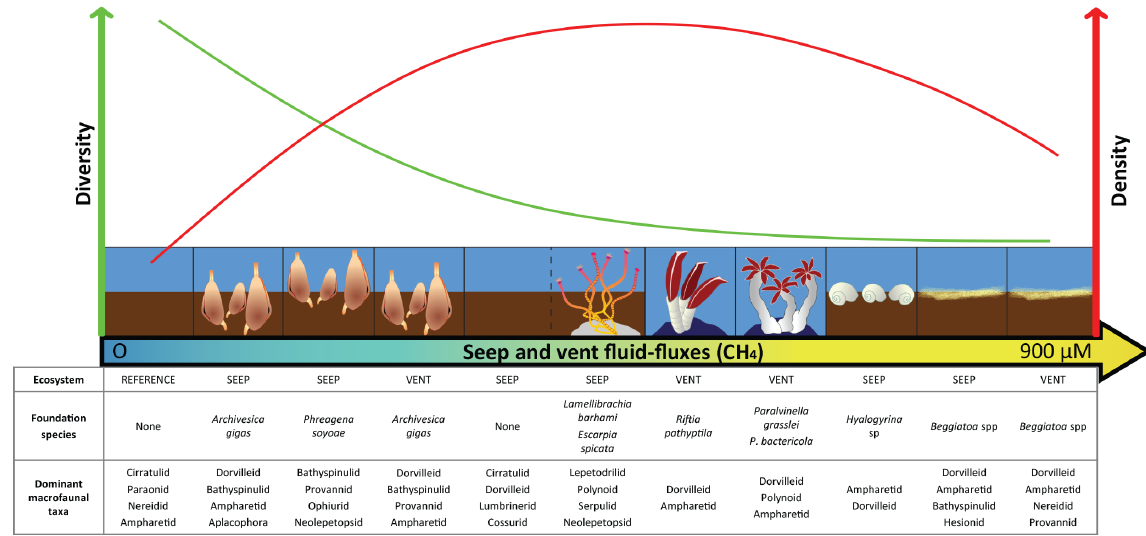
Figure 10. Conceptual diagram of macrofaunal diversity, density and composition patterns along a fluid-flux gradient in the chemosynthetic ecosystems of the Guaymas